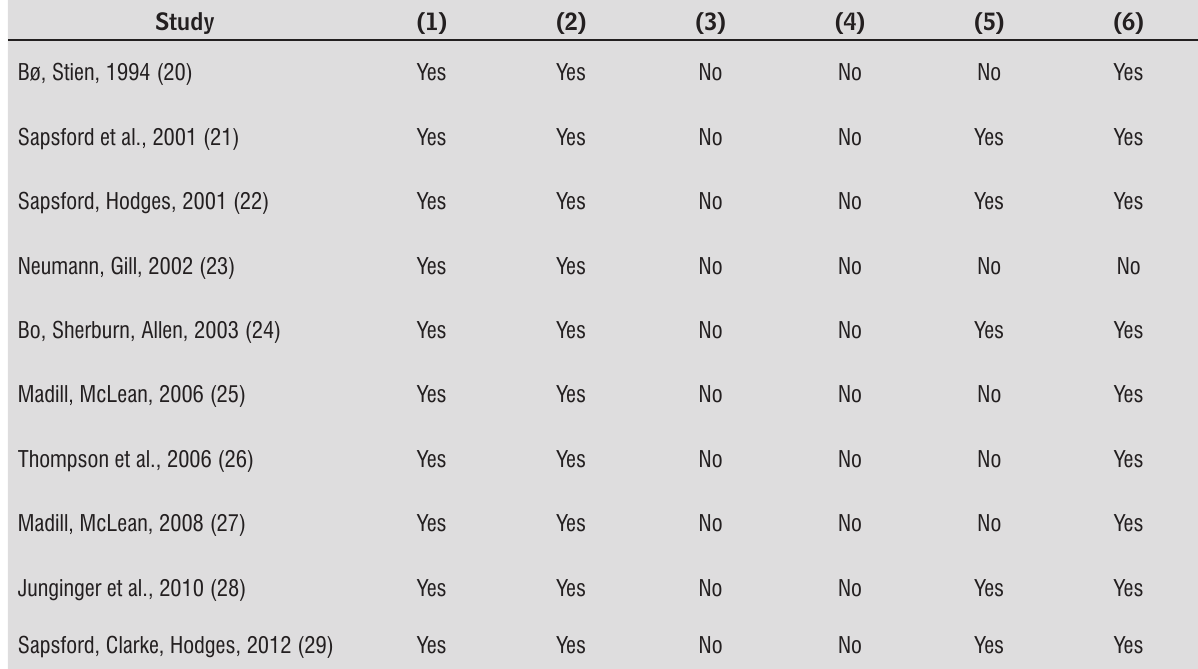
Table 3 - Description of the methodological quality of the studies